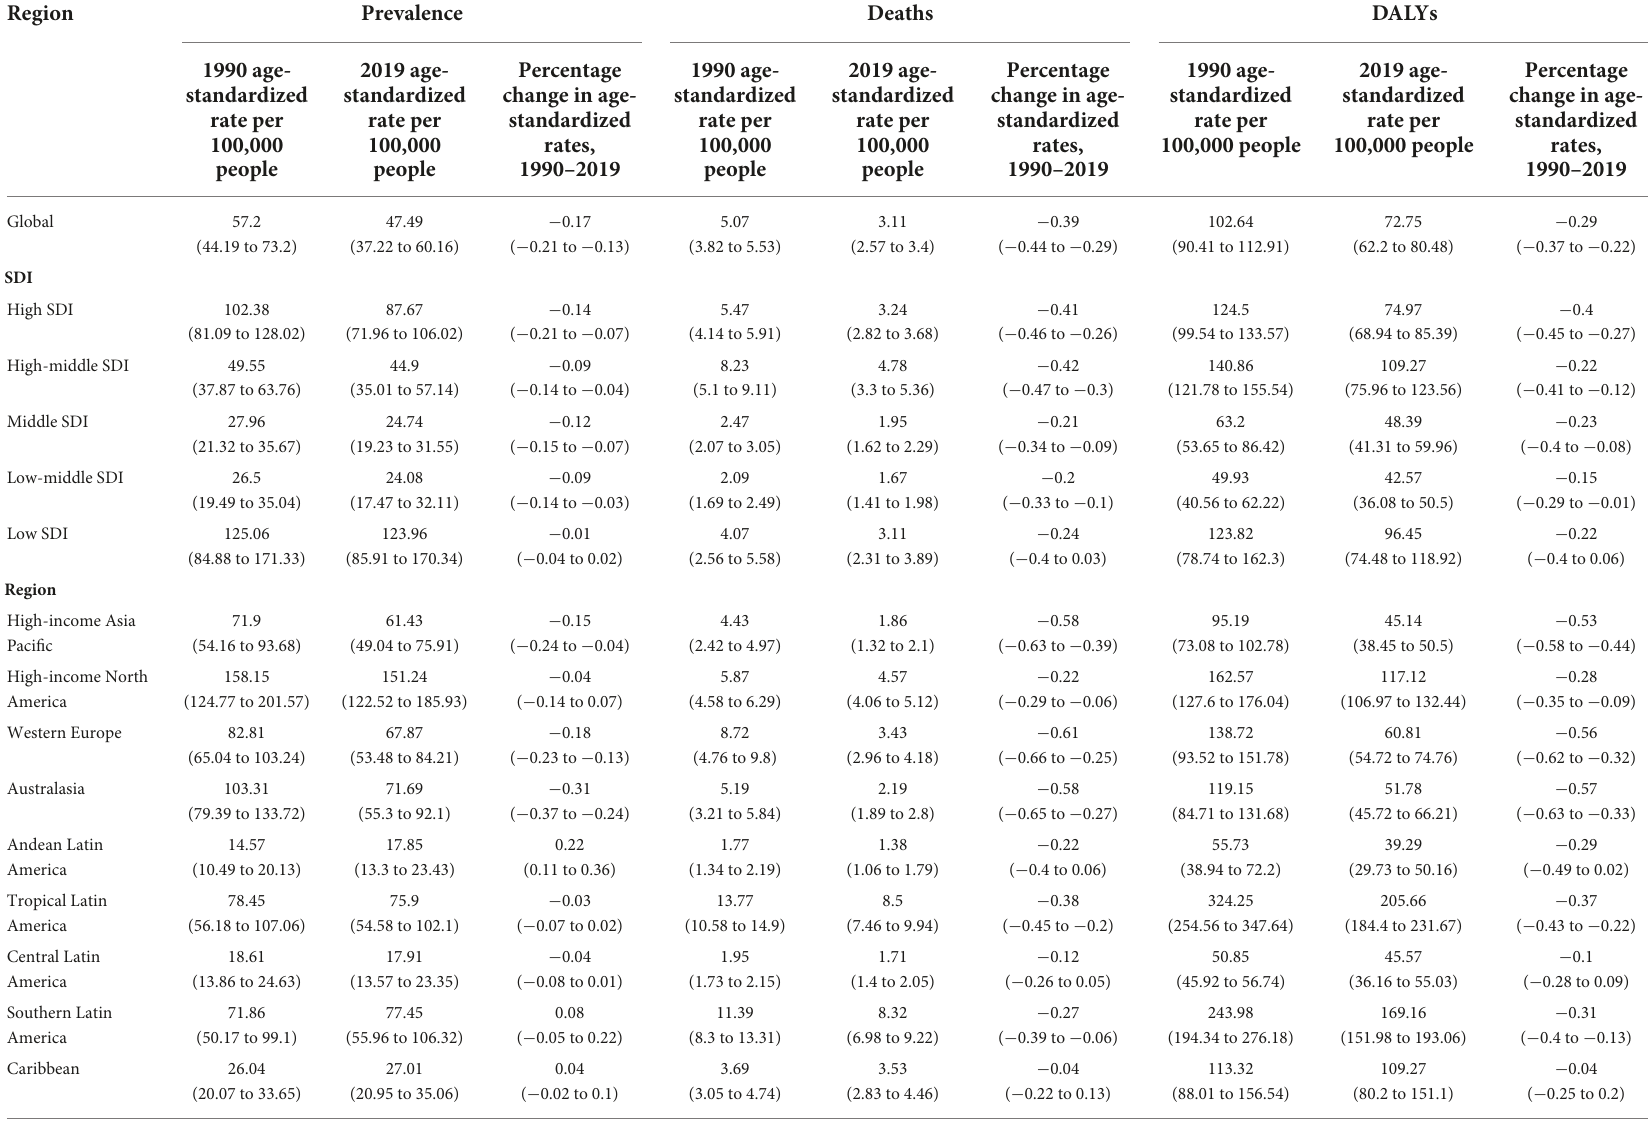
TABLE 3 Age-standardized prevalence, death, DALYs rates of other cardiomyopathy, and their percentage changes with 95% UIs from 1990 to 2019, both sexes.